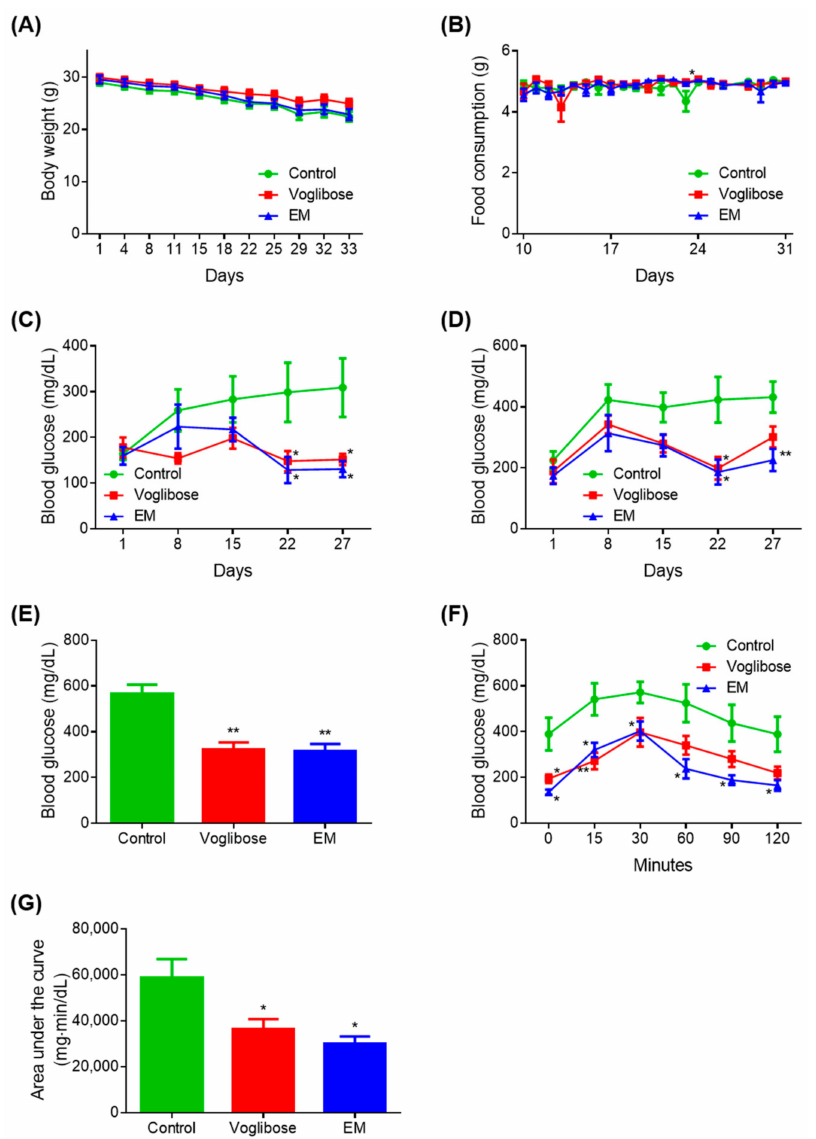
Figure 2. Antidiabetic effects of the enzyme mixture administration. ( A ) Body weight; ( B ) food intake; ( C ) blood glucose 4 h after fasting; ( D ) blood glucose 2 h after feeding; ( E ) blood glucose at autopsy 12 h after fasting; ( F ) blood glucose during the meal tolerance test; and ( G ) glucose area under the curve during the meal tolerance test. Data are expressed as the mean ± standard error of the mean (SEM; n = 7). * p < 0.05 and ** p < 0.01 vs. control (Student’s t